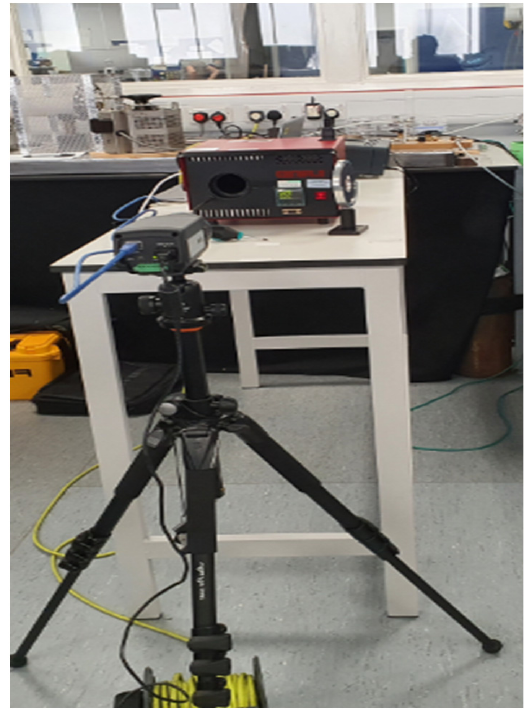
Figure 1. Calibration set up. IR detector mounted on tripod with lens directed to Black body radia-